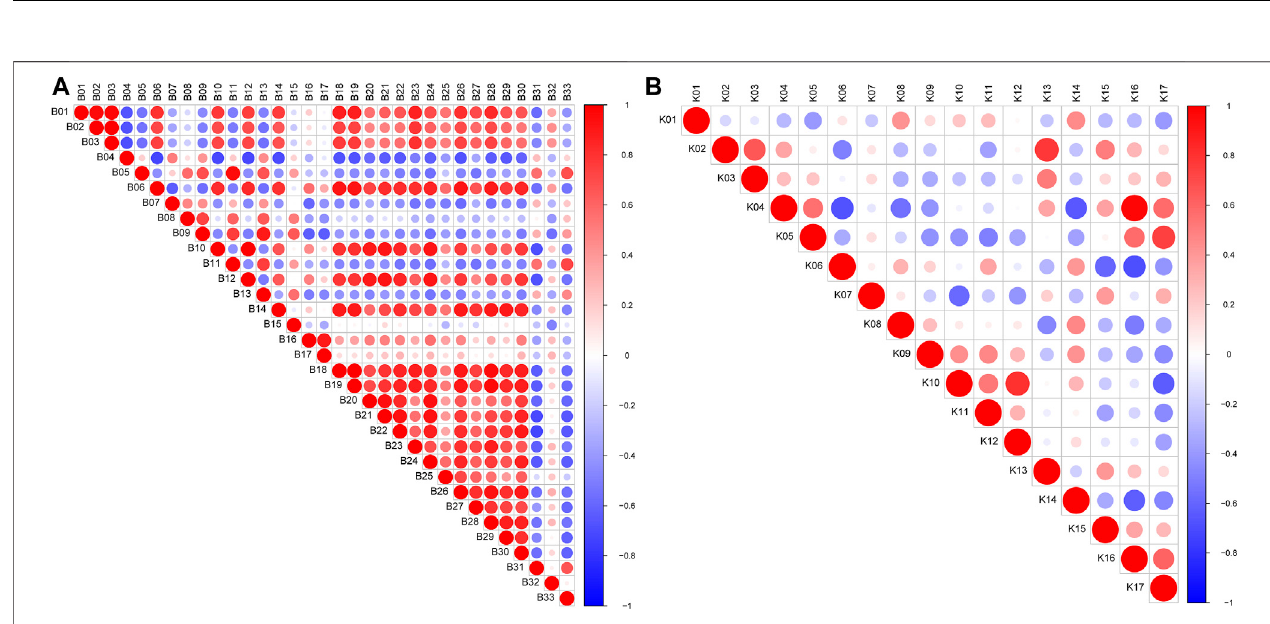
FIGURE 5 | Pearson ’ s correlations of marker metabolites detected by LC/MS in mice (A) serum and (B) kidney. Red color indicates positive correlation between compounds and blue color indicates negative correlation between compounds; and the darker the color, the stronger the correlation.